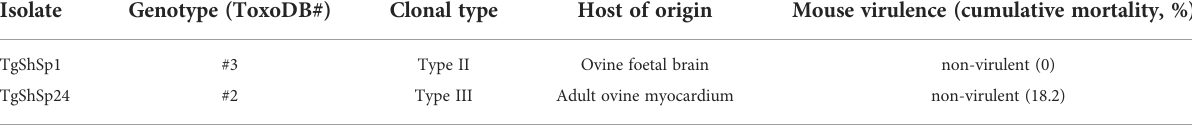
TABLE 1 Toxoplasma gondii isolates used in the present study. Isolate Genotype